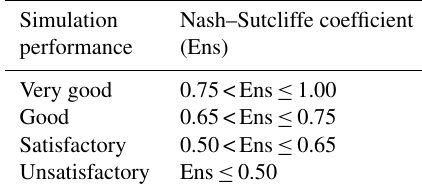
Table 2. SWAT performance of runoff simulations according to the Nash–Sutcliffe coefficient (Moriasi et al.,